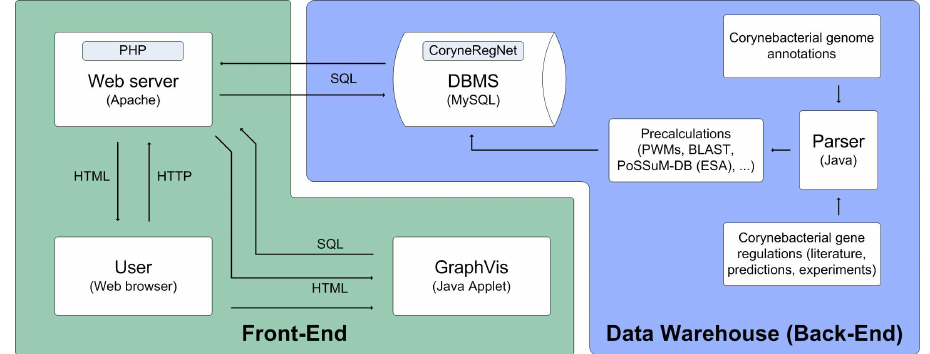
Figure 1: Overall structure of CoryneRegNet. The web-based front-end consists of two parts: HTML-based tables and the GraphVis applet. The back-end is described in Section